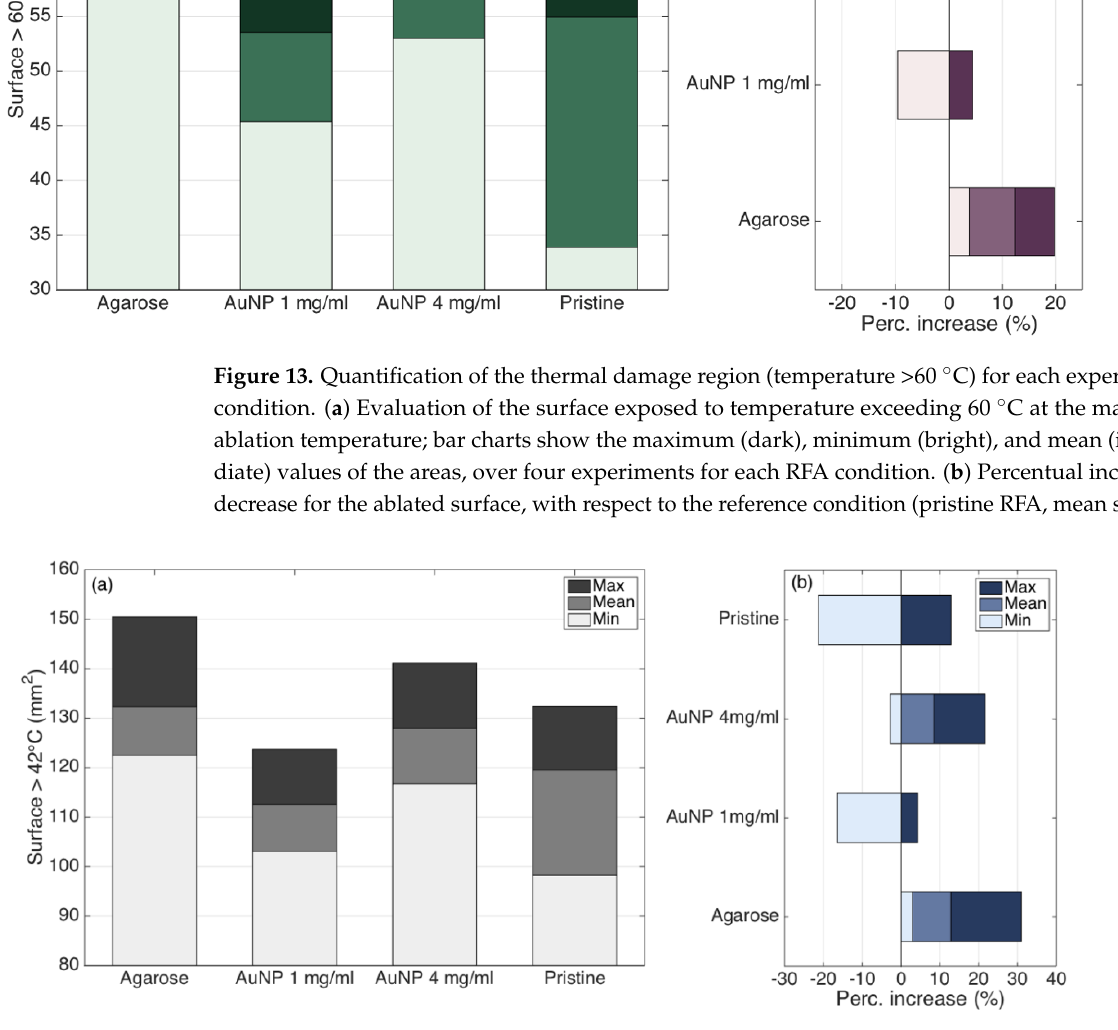
Figure 14. Quantification of the cytotoxic region (temperatures >42 °C) for each experimental condition. ( a ) Evaluation of the surface exposed to temperatures exceeding 42 °C at the maximum ablation temperature; bar charts show the maximum (dark), minimum (bright), and mean (intermediate) values of the areas, over four experiments for each RFA condition. ( b ) Percentual increase or decrease for the cytotoxic surface, with respect to the reference condition (pristine RFA, mean surface).